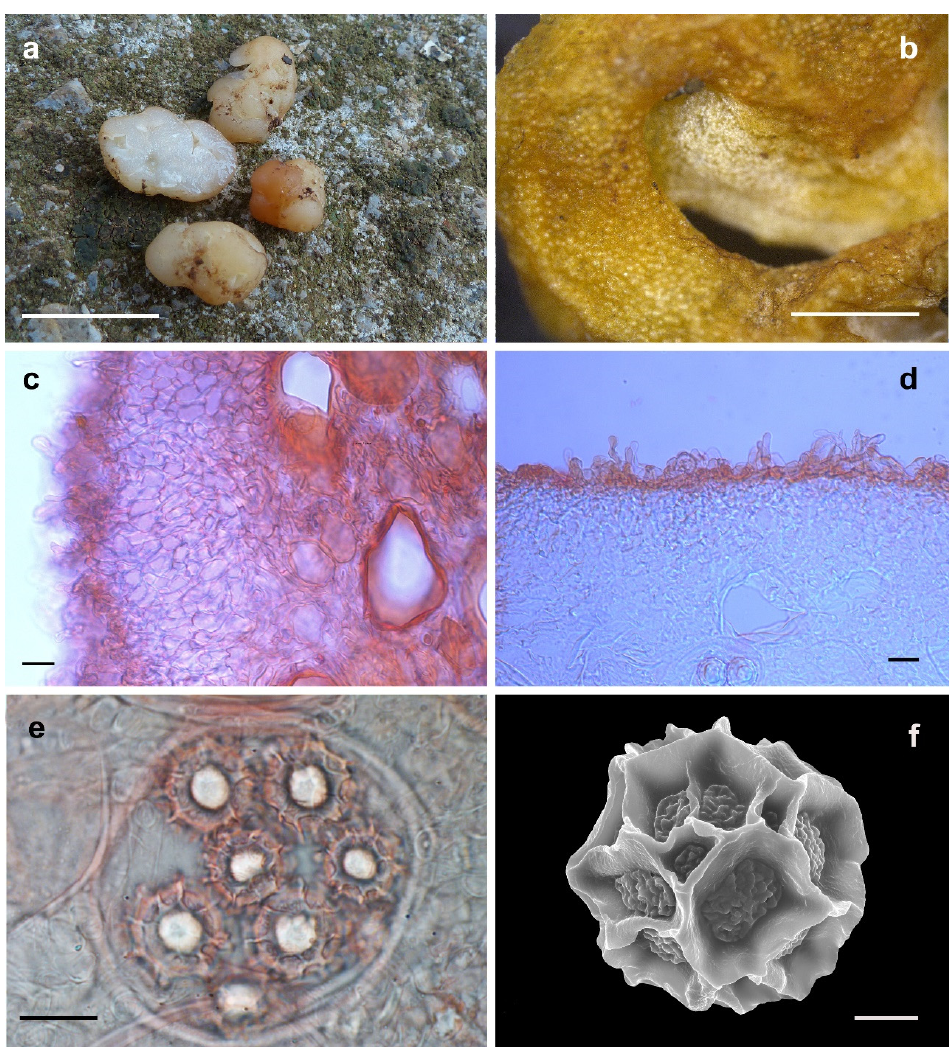
Figure 4. Hydnobolites subrufus (Holotype, HKAS95869). ( a ) Fresh ascomata and gleba; ( b ) dried ascoma; ( c , d ) peridium and paraphyses; ( e ) asci and ascospores under LM; ( f ) ascospore under SEM. Scale bars: a = 1 cm; b = 1 mm; c–e = 20 µm; f = 5 µm. 3.2.3. Hydnobolites lini S.P. Wan and F.Q. Yu, sp. nov.